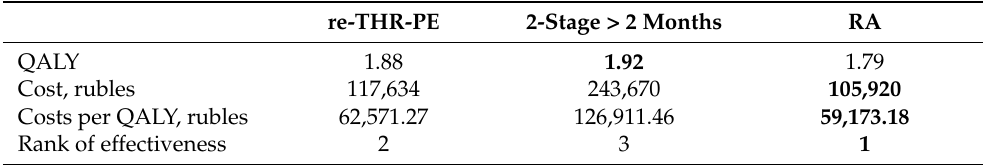
Table 5. Average costs for treatment methods in the retrospective group according to the Markov model simulations.